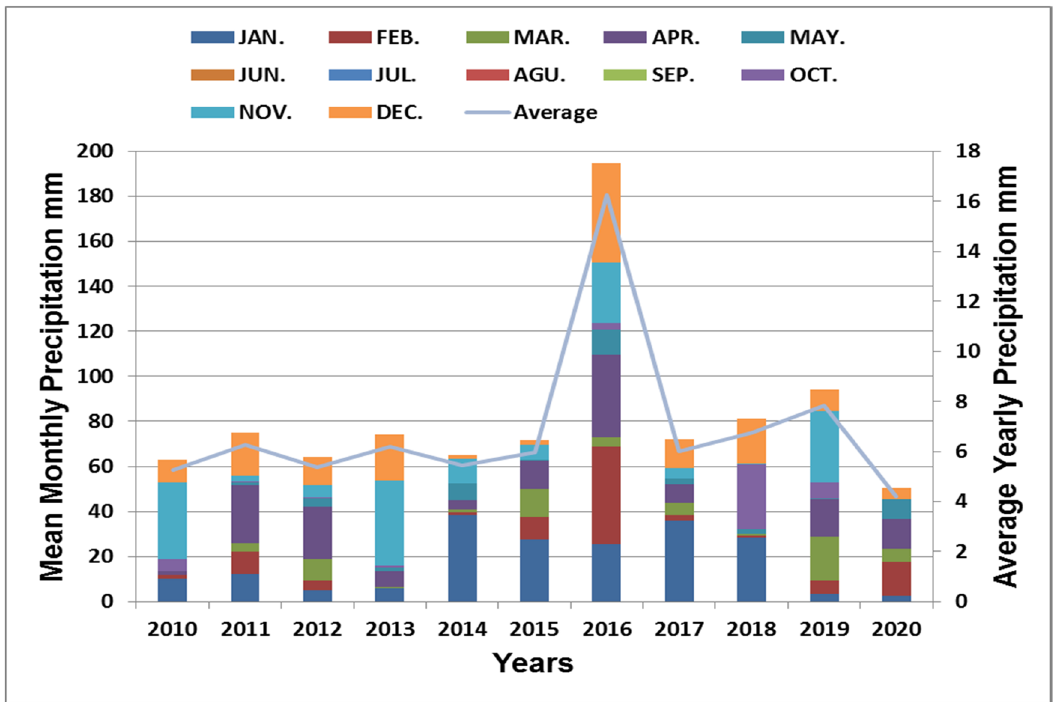
Figure 5: Average precipitation values per month and year over the period 2010 –